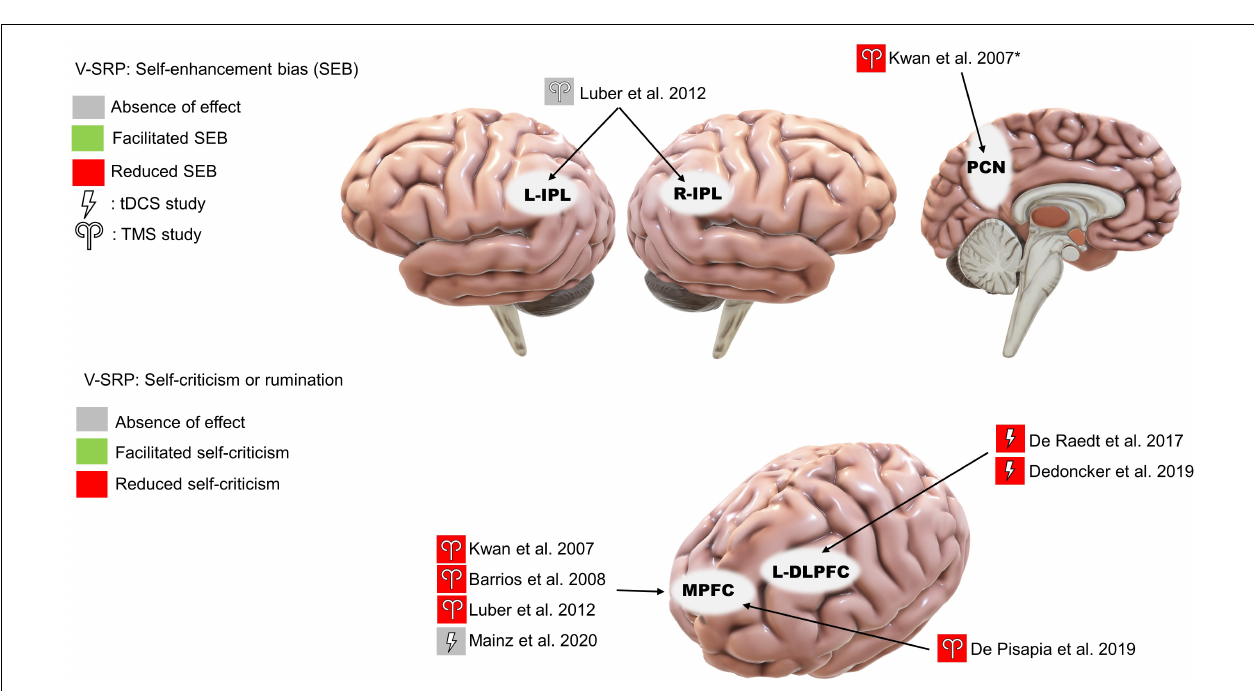
FIGURE 4 | Results of the reviewed studies on emotional SRP with tasks involving self-enhancement bias (SEB) and self-criticism or rumination. *Note: This result was only significant compared to supplementary motor area